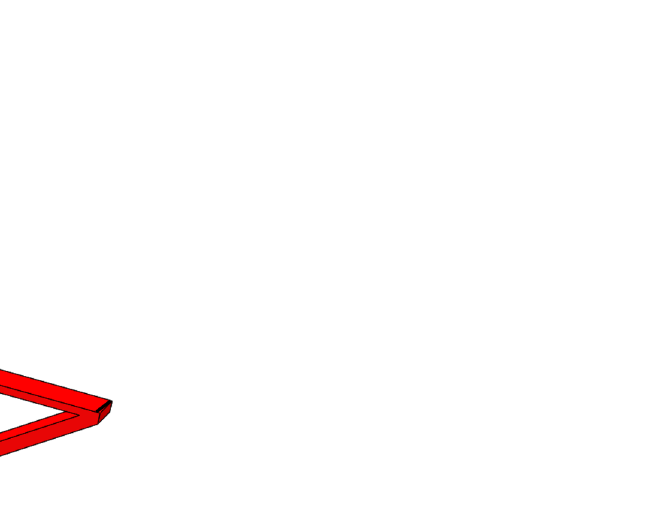
Figure 6. CAD software reconstructed